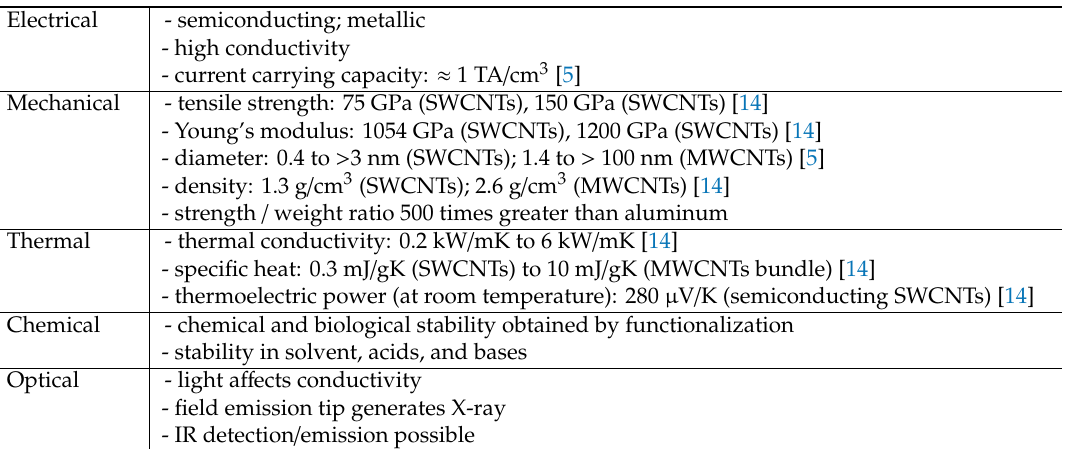
Table 1. CNTs Table 1. CNTs properties